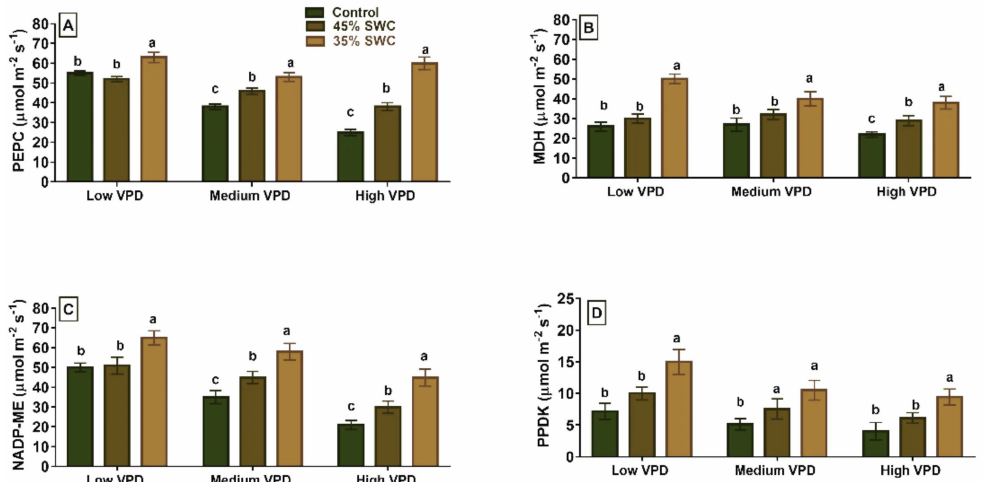
Figure 3. Enzymatic activity levels of four different enzymes ( A ) PEPC ( B ) MDH, ( C ) NADP-ME, and ( D ) PPDK ( µ mol m − 2 s − 1 ) in response to water limited stress (45% and 35% soil water content SWC) and evaporative demand (low, medium, and high vapor pressure deficit (VPD)). Bars (Average ± S.E.) represented with the same alphabet means the values were not significantly different at p < 0.05